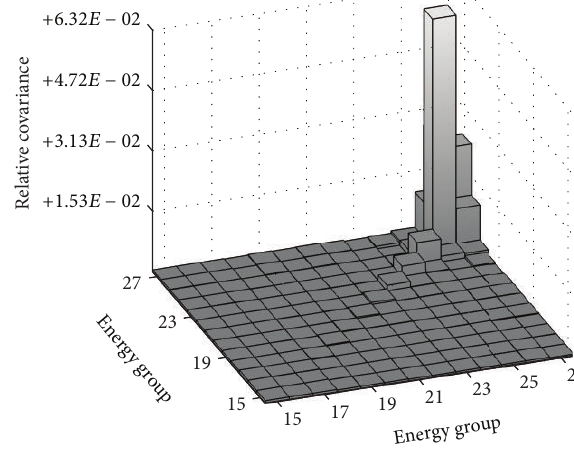
Figure 20: 𝜎 U 235 𝑓 covariance at 𝜎 0 = 3.0𝐸 + 4𝑏 .